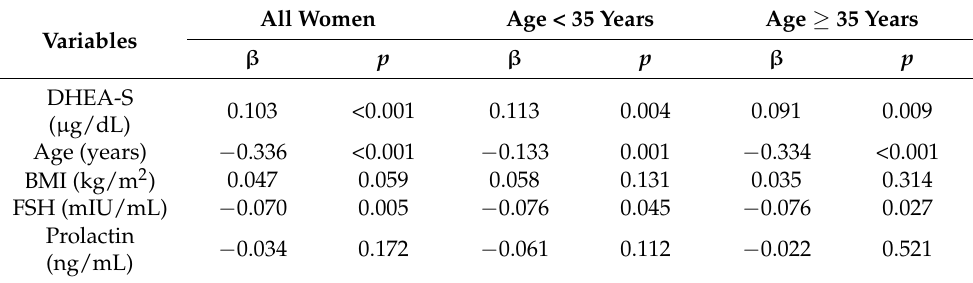
Table 2. Multiple linear regression analysis on the correlations between serum dehydroepiandros- terone sulphate (DHEA-S) and anti-Mullerian hormone (AMH) levels after adjustment for potential